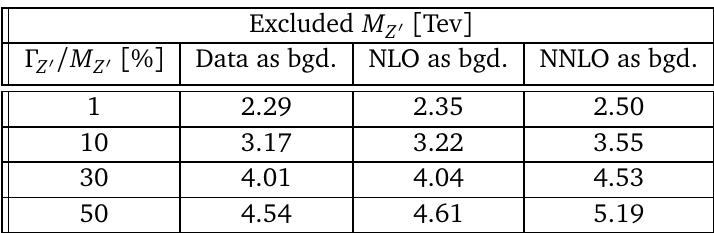
obtained in this Z ′